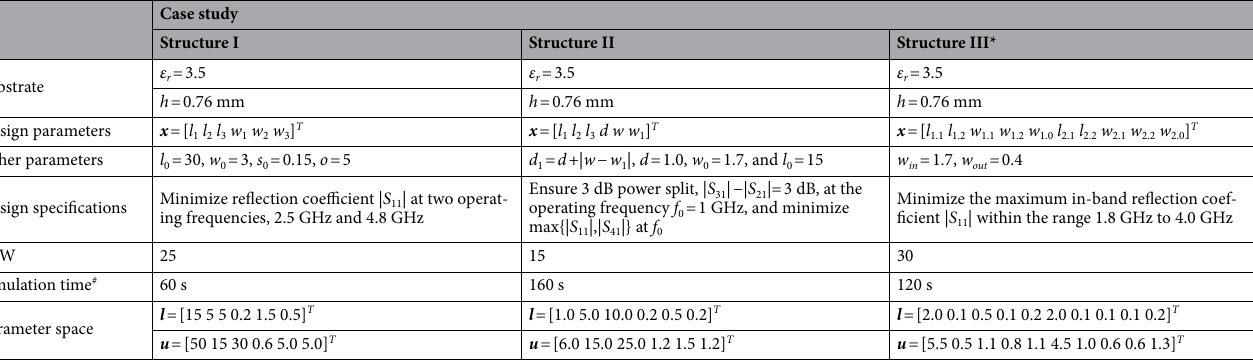
Table 1. Verification structures. *Input and output line widths, w in and w out , set to ensure 50-Ω input and 100-Ω output impedance. # EM simulations have been performed on Intel Xeon 2.1 GHz machine with 64 GB RAM.